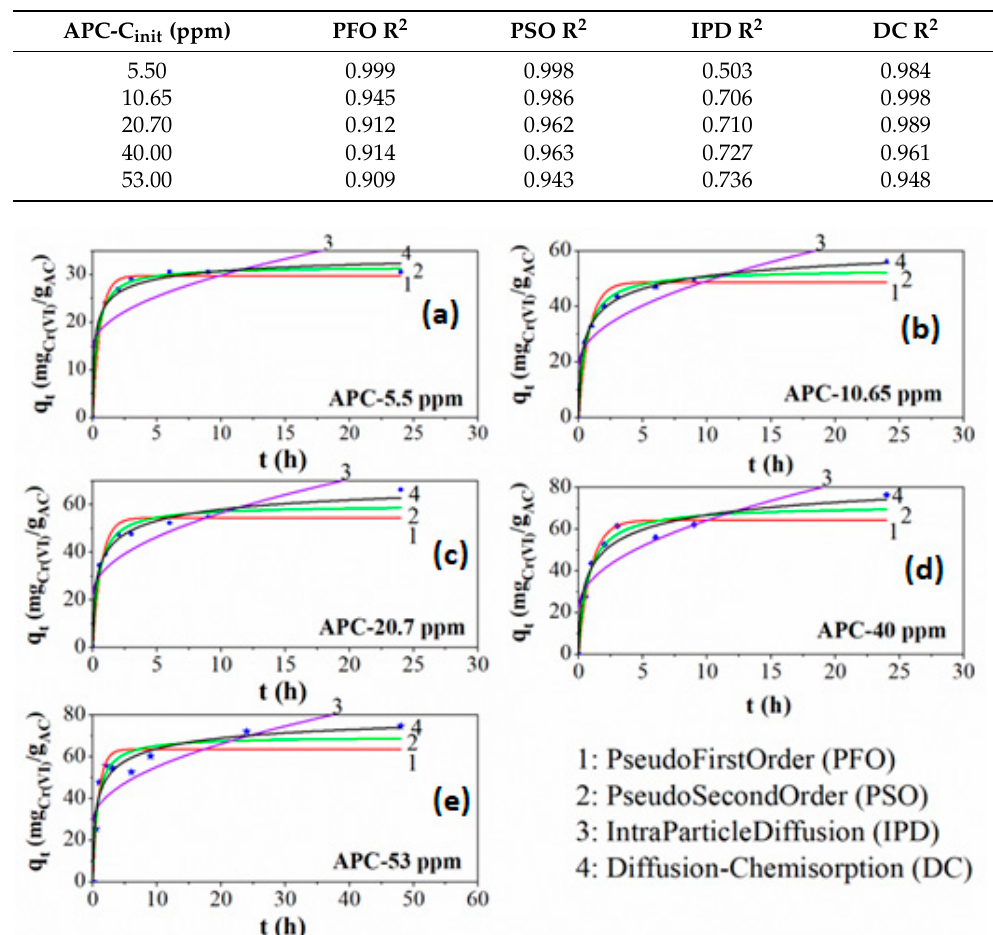
Table 3. R 2 correlation coefficient values provided by Levenberg–Marquardt least-square fitting algorithm upon the APC experimental dataset.